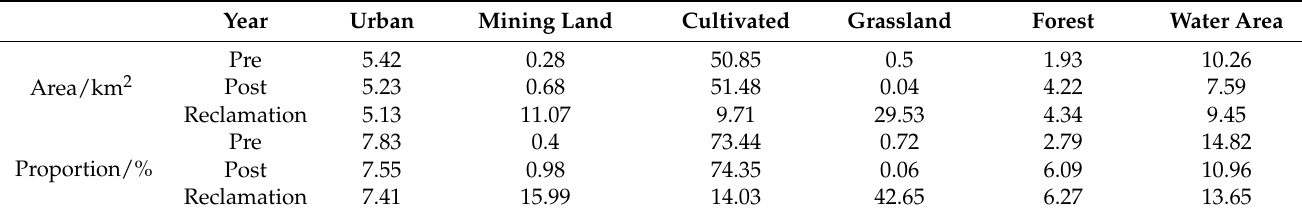
Table 5. Land use types in the study area.